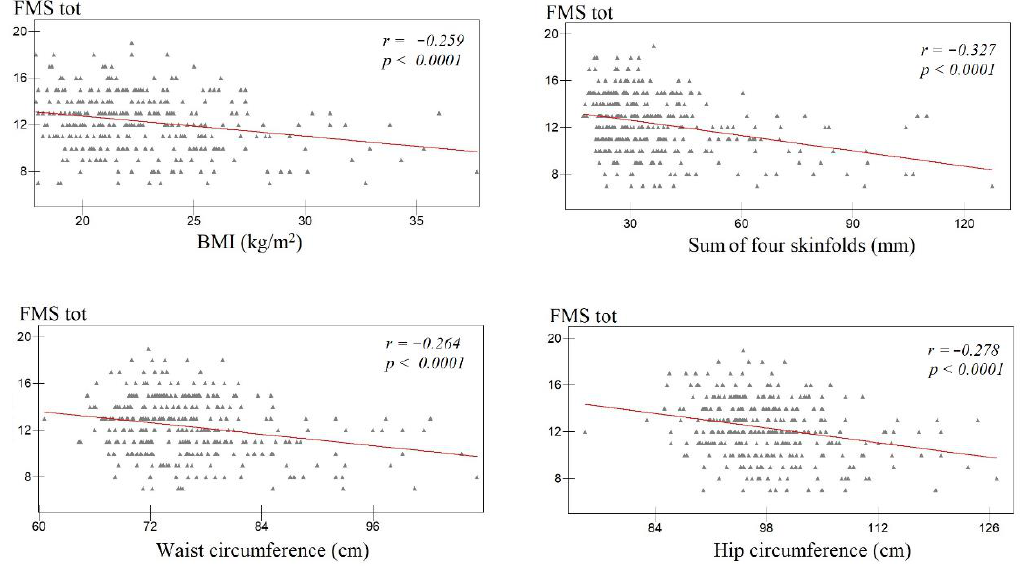
Figure A3. Correlation between BMI, sum of four skinfolds, waist and hip circumference and total FMS score among boys.